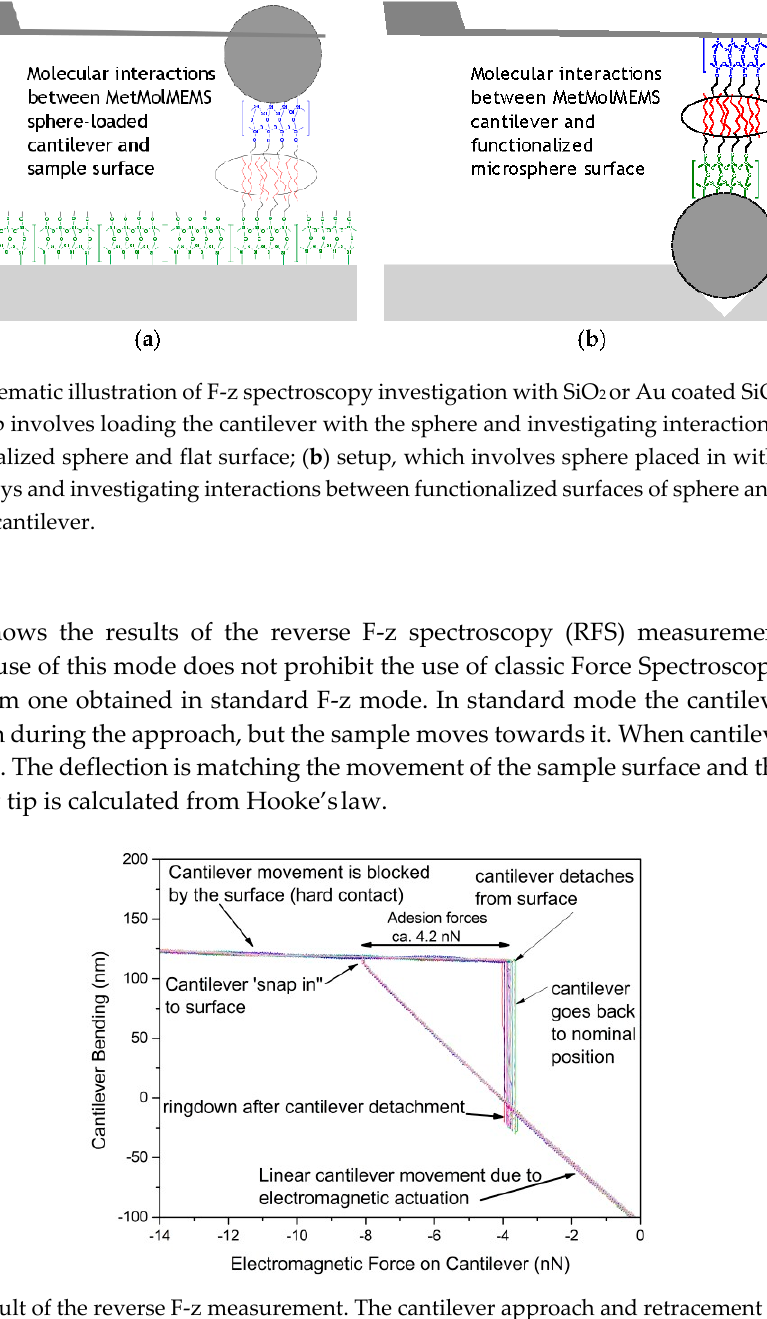
Figure 3. Result of the reverse F-z measurement. The cantilever approach and retracement is realized by the modulating current in Lorentz loop. This setup does not require Z -axis piezoelectric